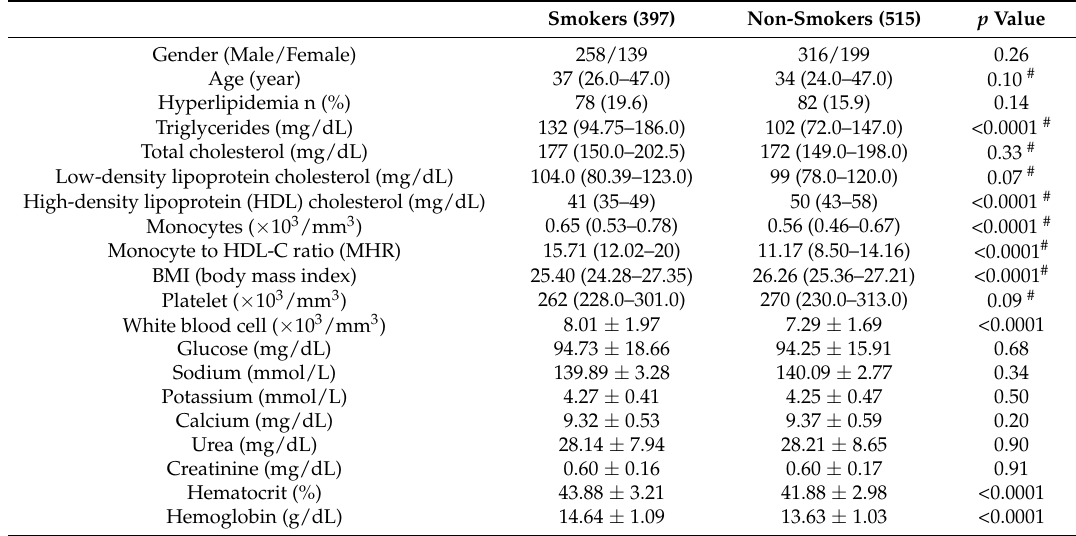
Table 1. Inter-group comparison of demographic and laboratory data.